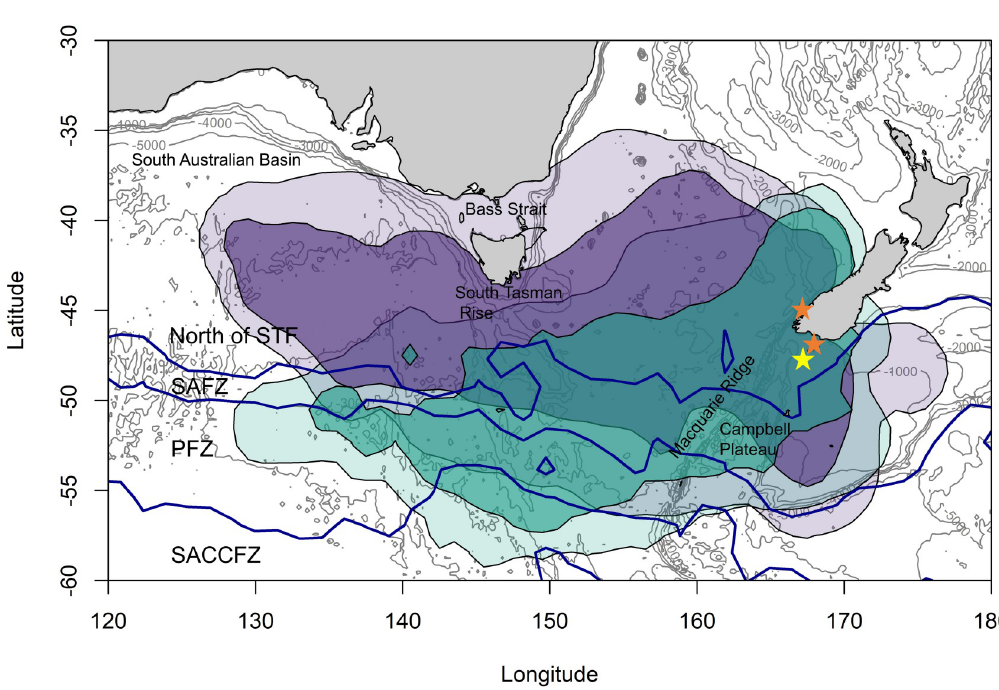
Fig 2. Distribution of Fiordland and Snares penguins during the post-moult non-breeding season. Coloured fill indicates 50% (core usage; darker) and 90% (peripheral distribution; paler) utilisation distributions for Fiordland penguins (turquoise) and Snares penguins (purple). The orange stars indicate the Fiordland breeding colonies along the New Zealand mainland coast of Southwestland and Fiordland and on Codfish Island off the south of New Zealand and the yellow star indicates the Snares Islands where Snares penguins breed. North of STF = North of the Sub-Tropical Front, SAFZ = Sub-Antarctic Frontal Zone, PFZ = Polar Frontal Zone and SACCFZ = Southern Antarctic Circumpolar Current Frontal Zone. Grey lines represent bathymetric contours with 1000 m